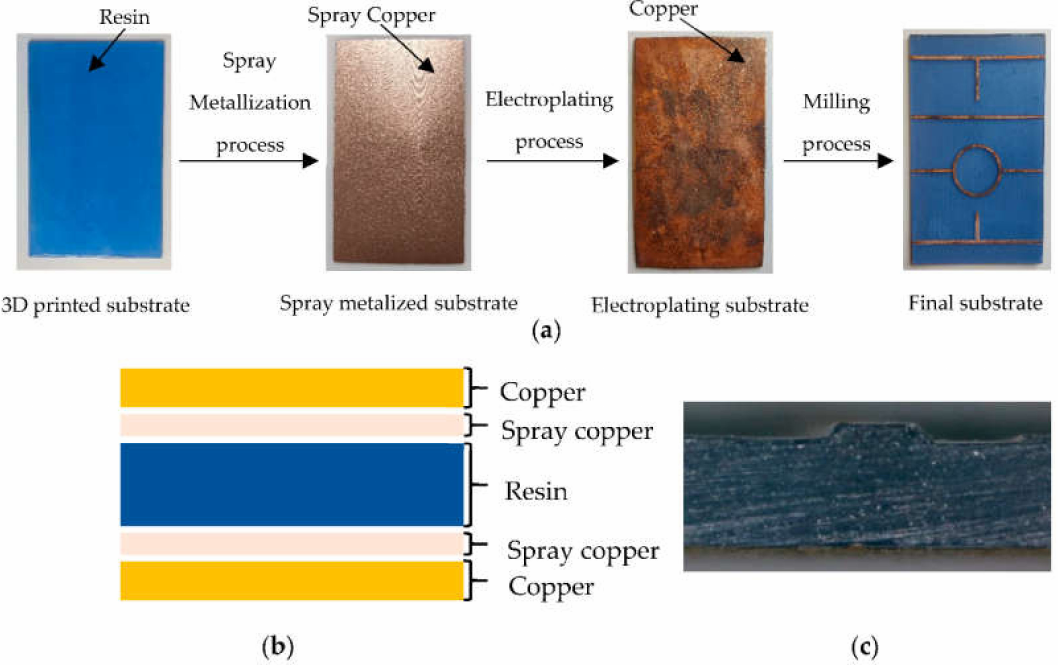
Figure 3. Printed circuit board manufacturing process with copper spray and electroplating: ( a ) step by step description; ( b ) cross-section of the manufactured substrate; ( c ) transmission line end